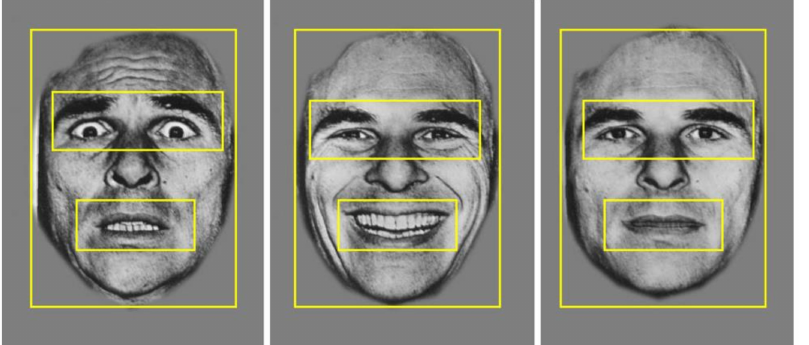
Figure 2. Example of the three regions of interest: the whole face, the eyes, and the mouth, applied across stimuli for data